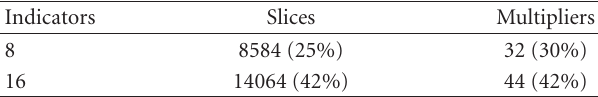
Table 1: Synthesis result with floating point